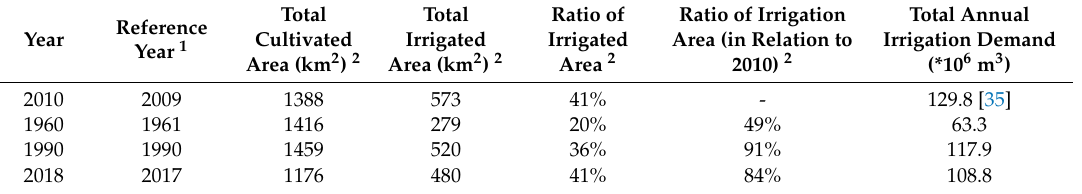
Table 4. Estimation of irrigation demands for Spercheios river